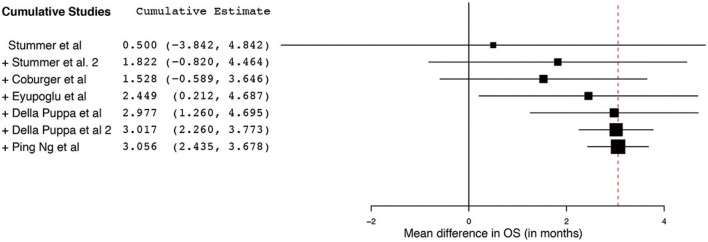
Cumulative regression analysis demonstrating the temporal trend of mean difference (95% confidence interval [CI]) in overall survival among patients with primary high-grade glioma treated using 5-aminolevulinic acid–guided surgical resection vs. conventional microsurgical resection. Used with permission from Barrow Neurological Institute, Phoenix, Arizona.